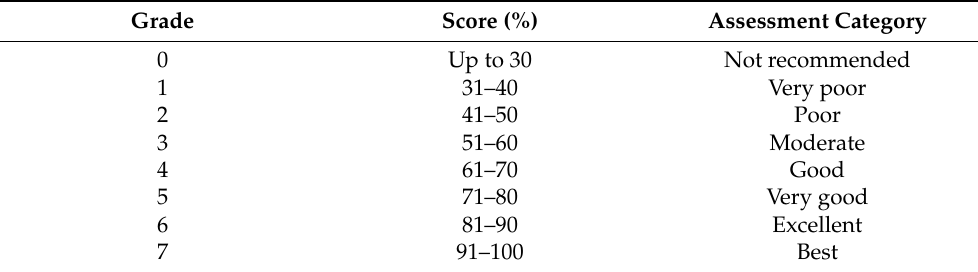
Table 3. Plant species classification using anticipated performance index